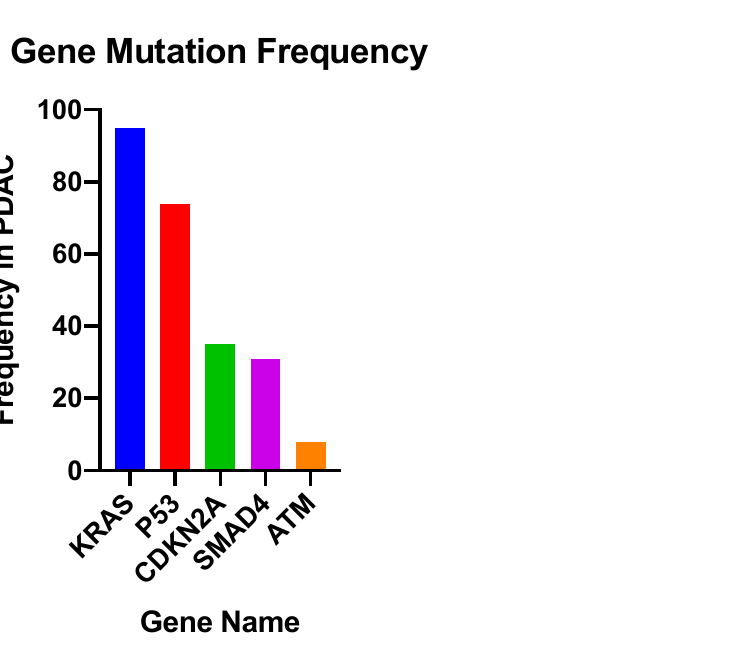
Figure 2. Most common somatic common gene mutations in PDAC [67,68].